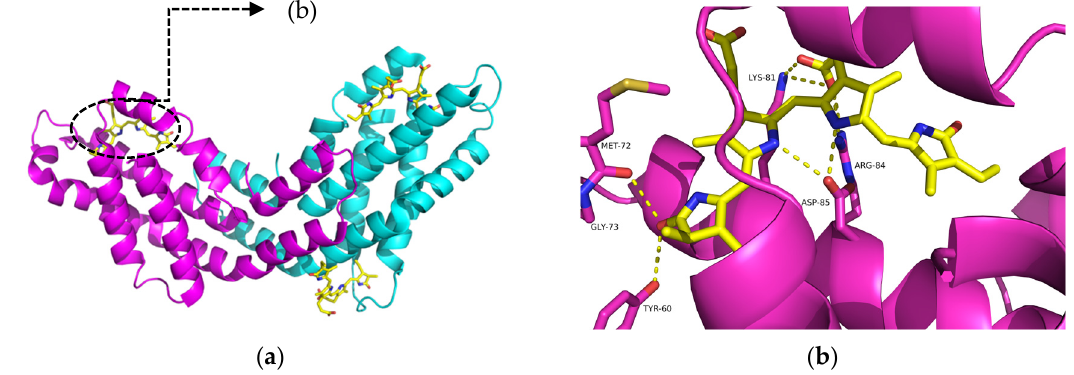
Figure 1. Structure of C-phycocyanin ( a ) and phycocyanobilin (yellow) with its secondary interaction of amino acid residues on the α subunit ( b ). The α and β subunits are colored in pink and blue, respectively. Bovine serum albumin (BSA) is a helical protein containing 583 amino acids, and is the